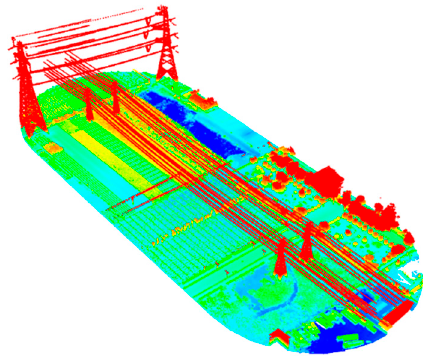
Figure 6. Point cloud data.